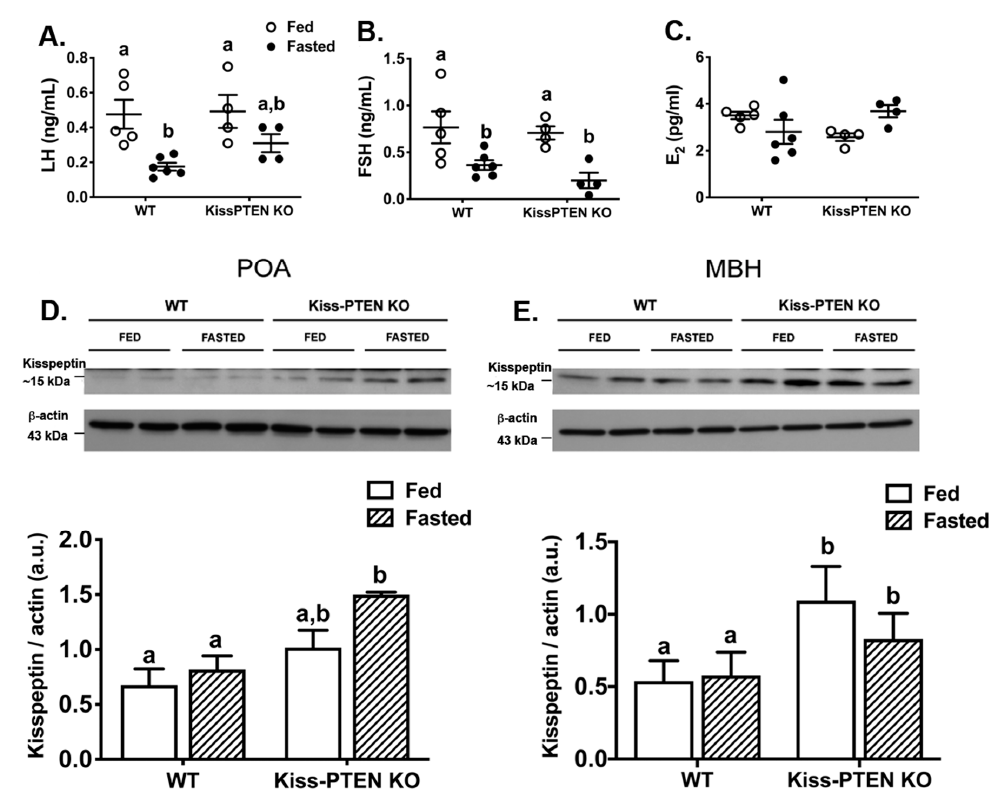
Figure 7. Kiss-PTEN KO females maintain basal LH after fasting and express more hypothalamic kisspeptin protein compared to fasted WT females. ( A ) Terminal plasma LH, ( B ) FSH, and ( C ) E 2 levels in WT and Kiss-PTEN KO females that were either left fed or fasted for 48 h. All females were sacrificed at diestrus ( n = 4–6 mice / diet / genotype). ( D ) Immunoblots performed for kisspeptin in the preoptic